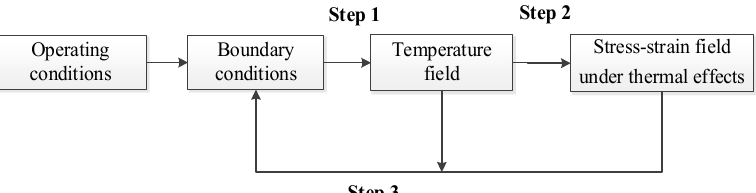
Figure 1. Thermal-mechanical